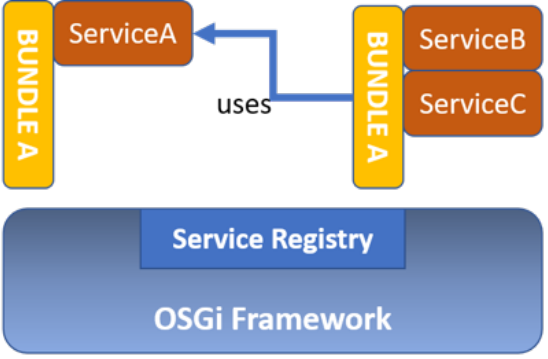
Figure 4. OSGi Framework with Bundles and